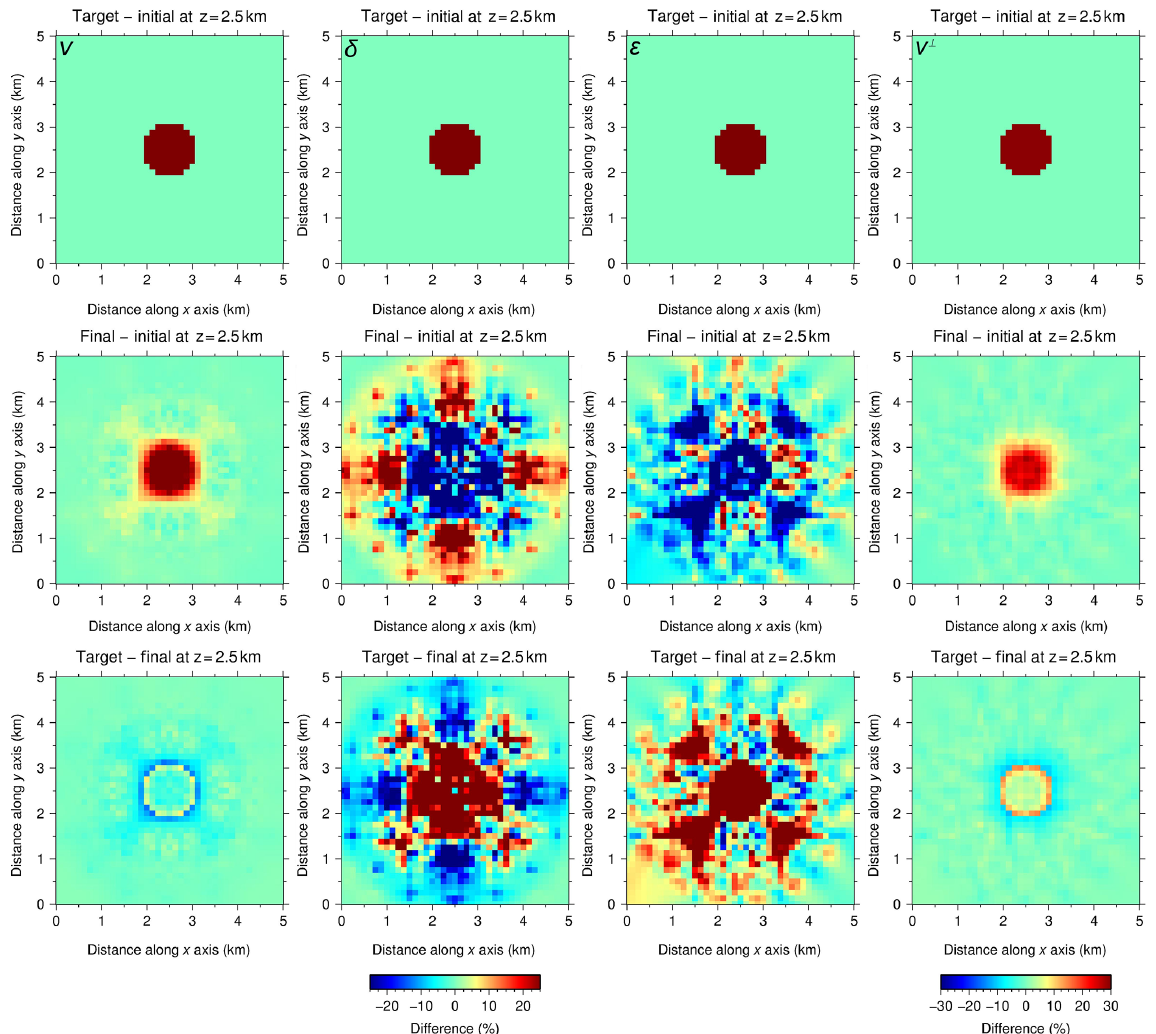
Figure 6. Same as Fig. 5 but with P[ v ⊥ ]. ε is derived from Eq. (2). The quality of the recovery is correlated with sensitivity (Fig. 2). Both velocities are satisfactorily recovered. The magnitude of the anomaly in v is better recovered than for P[ ε ], whereas the opposite occurs for v ⊥ . Anomaly boundaries for both velocities are not as well determined as for P[ ε ]. ε and δ are not